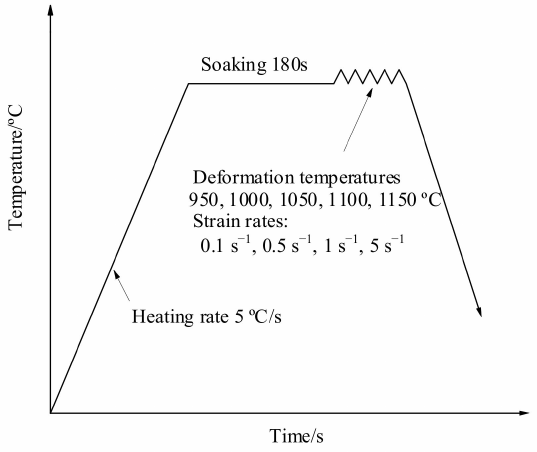
Figure 2. Experimental process of hot tensile